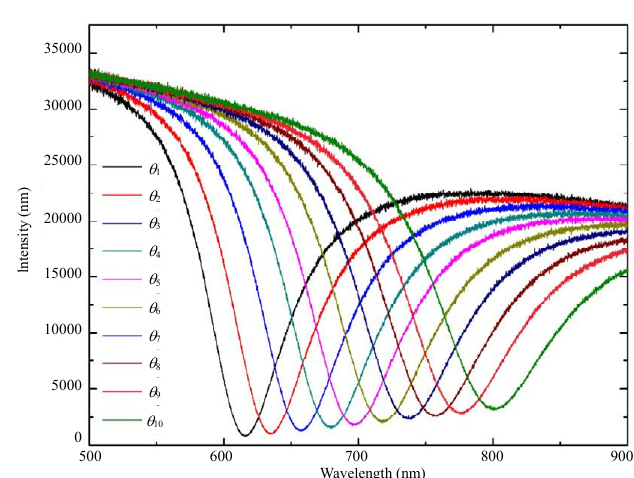
Fig. 5 SPR measurement curves affected by SPD2 (the reflectivity curves from left to right correspond to incident angles θ 1 , θ 2 , θ 3 , θ 4 , θ 5 , θ 6 , θ 7 , θ 8 , θ 9 , and θ 10 , respectively).